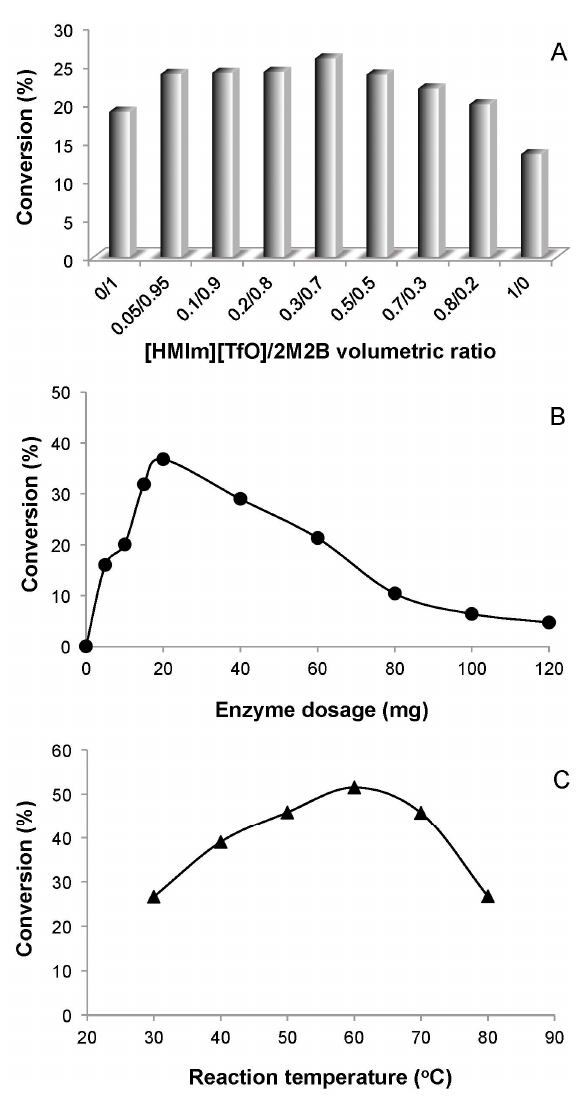
Figure 4. Lipozyme TLIM-catalyzed transesterification of glucose and vinyl laurate in the [HMIm][TfO]/2M2B bisolvent system: Effect of IL/2M2B volumetric ratio ( A ); enzyme dosage ( B ); and reaction temperature ( C ) on the conversions obtained in 24 h.